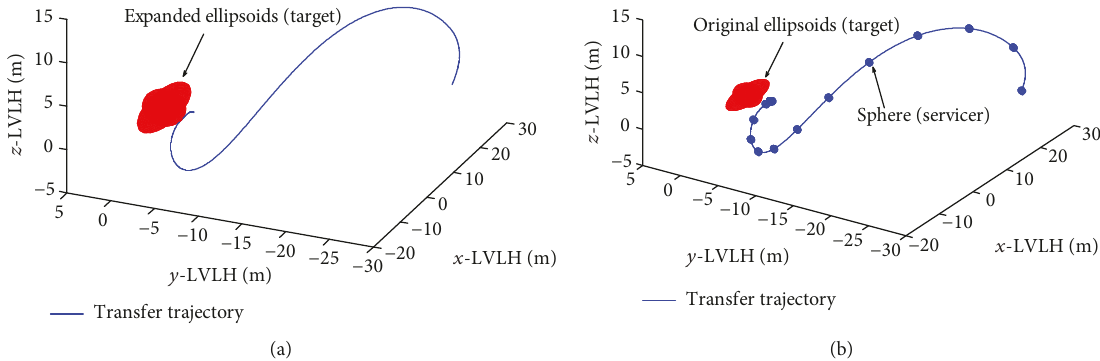
Figure 7: Three-dimensional plot of the approaching trajectories resolved in the target body- fi xed frame. (a) Servicer ’ s center relative to target ’ s expanded ellipsoids. (b) Servicer ’ s sphere relative to target ’ s original ellipsoids.